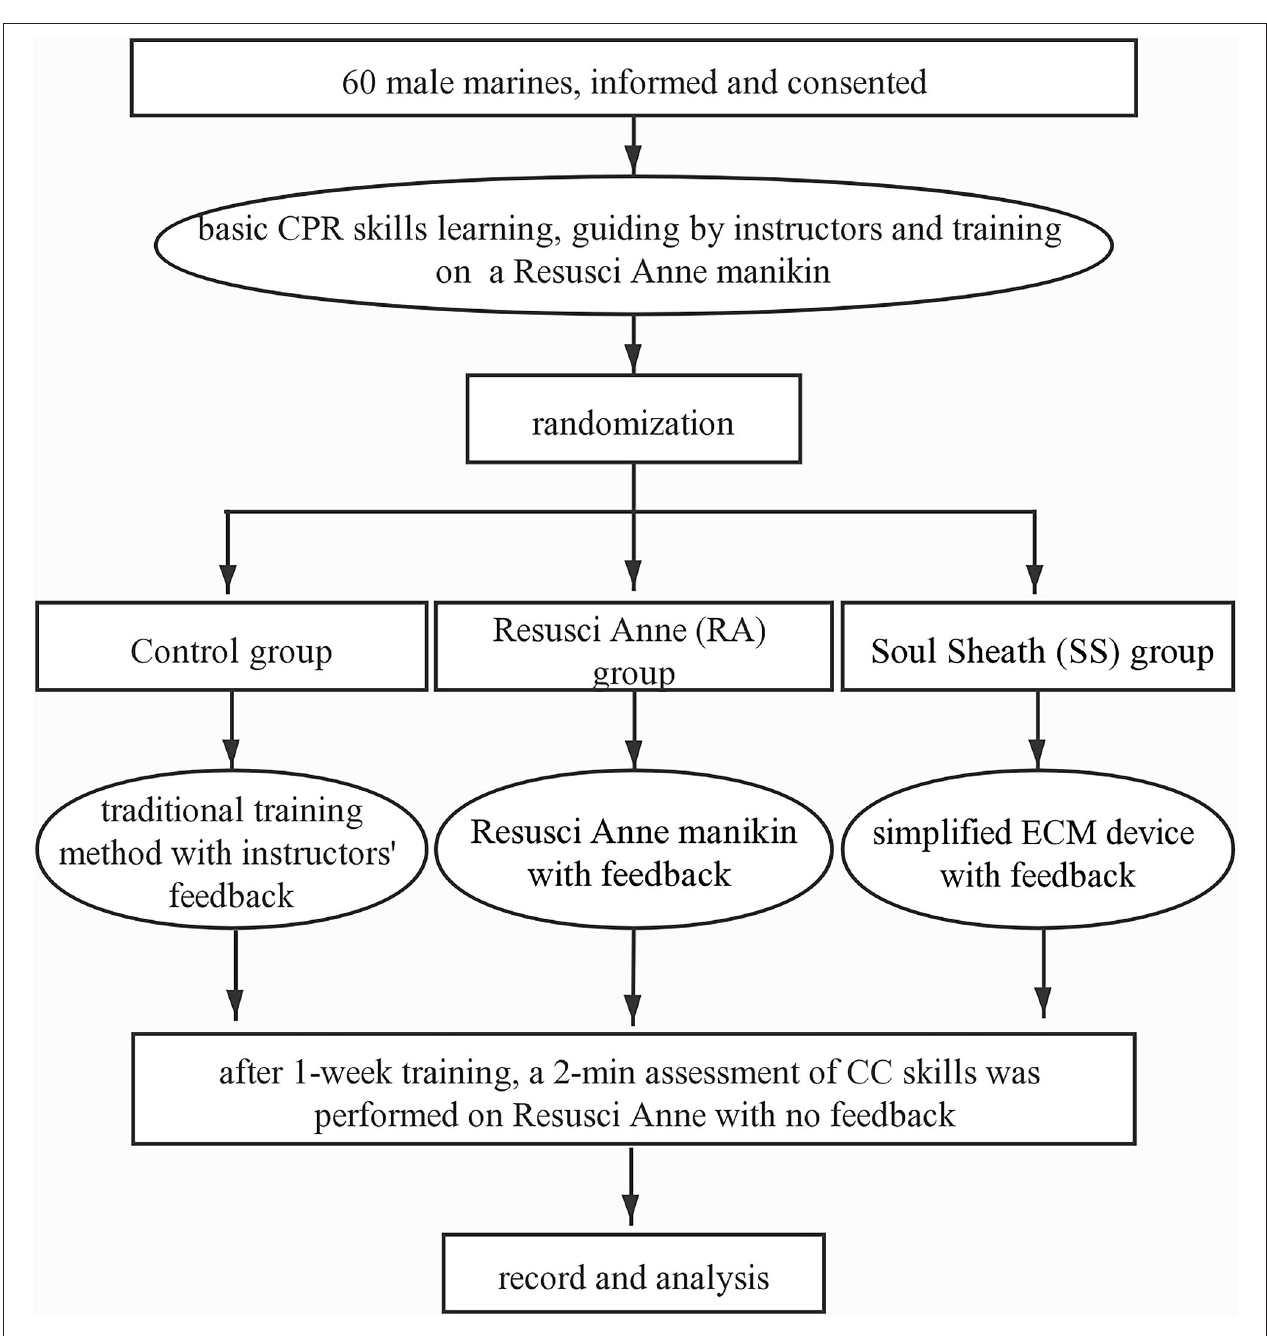
FIGURE 2 | Flowchart. CPR, cardiopulmonary resuscitation; ECM, external cardiac massage; CC, chest compression.